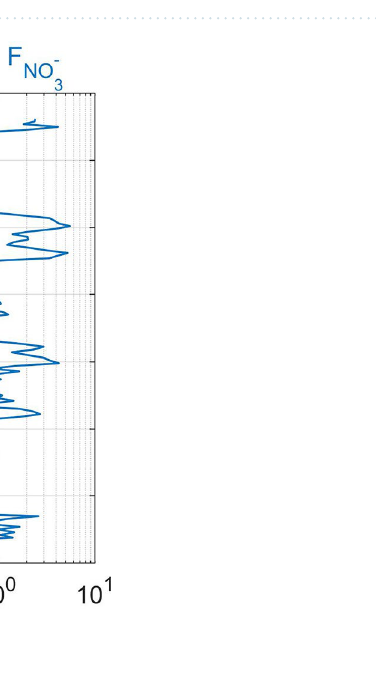
Figure 6. Vertical section of nutrients and vertical turbulent nutrient fluxes: ( a ) nitrate concentration, ( b ) phosphate concentration, ( c ) vertical turbulent nitrate flux, ( d ) vertical turbulent phosphate flux. Nutrient concentrations were estimated from potential temperature within a range of 15–27 °C. Contour lines show isopycnals and the thick solid line represents the depth of the surface mixed layer.